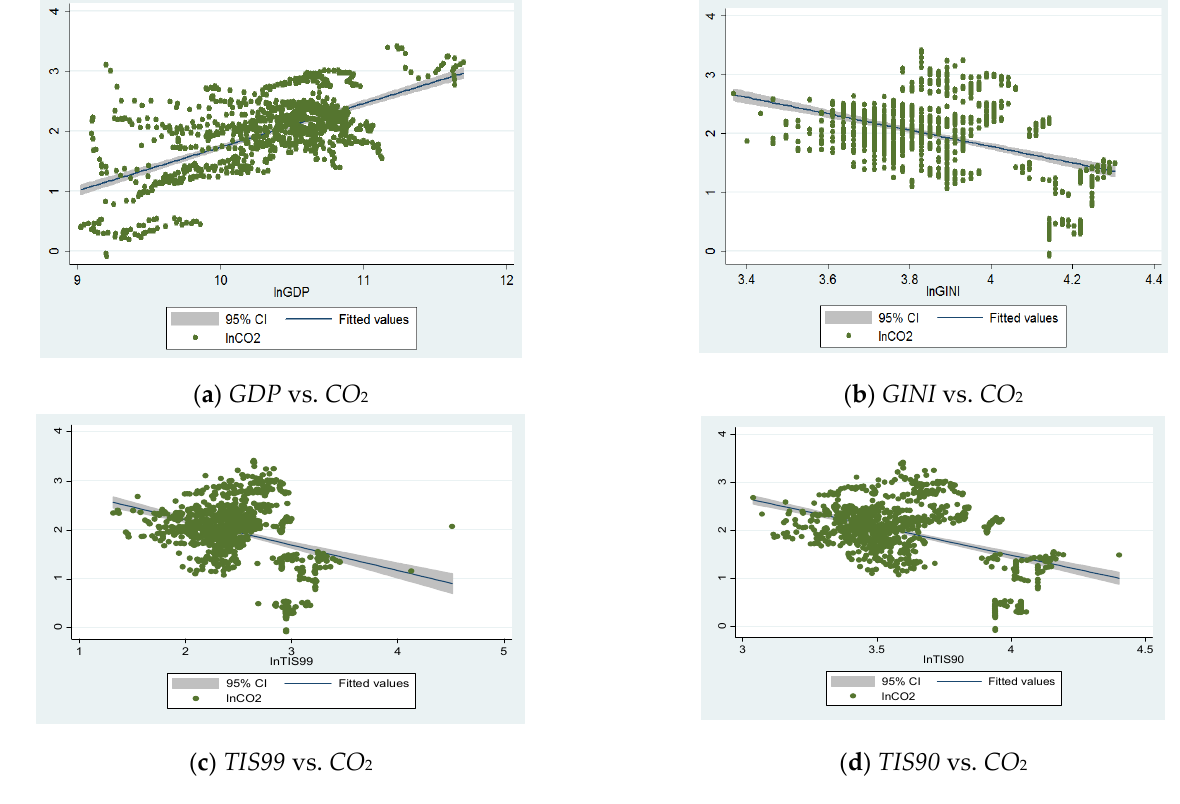
Figure 2. The simple relationships of income inequality indexes and GDP for CO 2 emissions. Note: All variables are taken in the logarithmic form. Source: Author’s own elaboration based World Bank (2022) WDI [29] and WID (2022) [30].